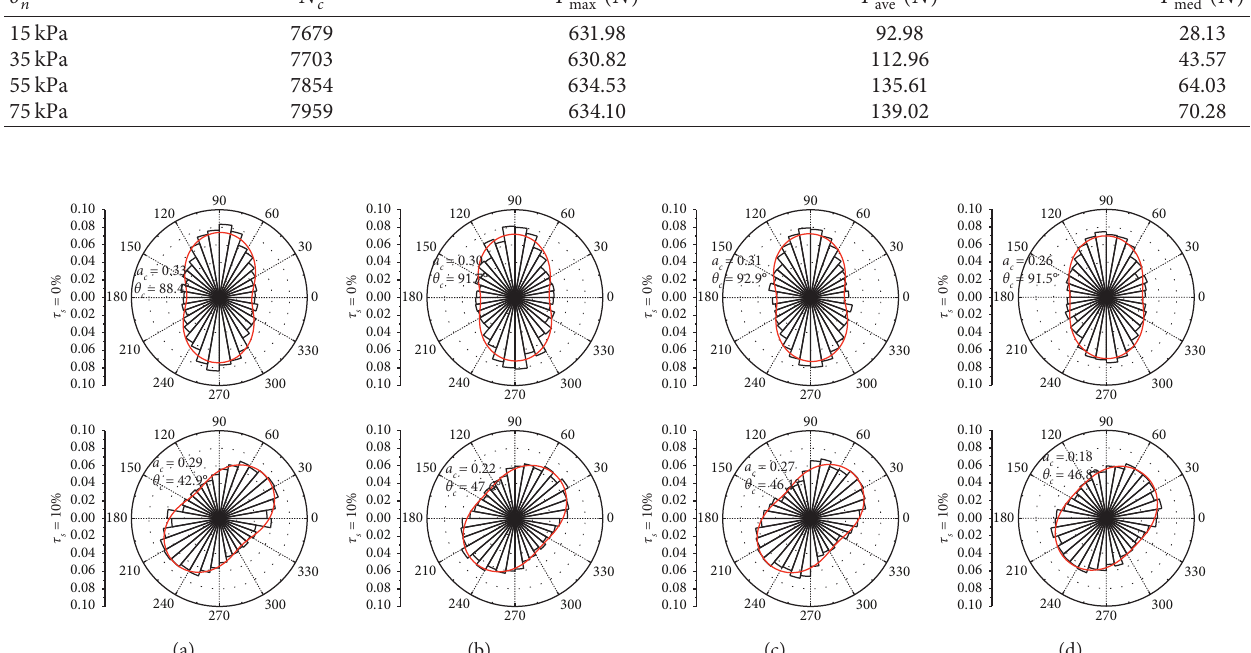
Figure 7: Rose diagrams of contact normal distribution at ε